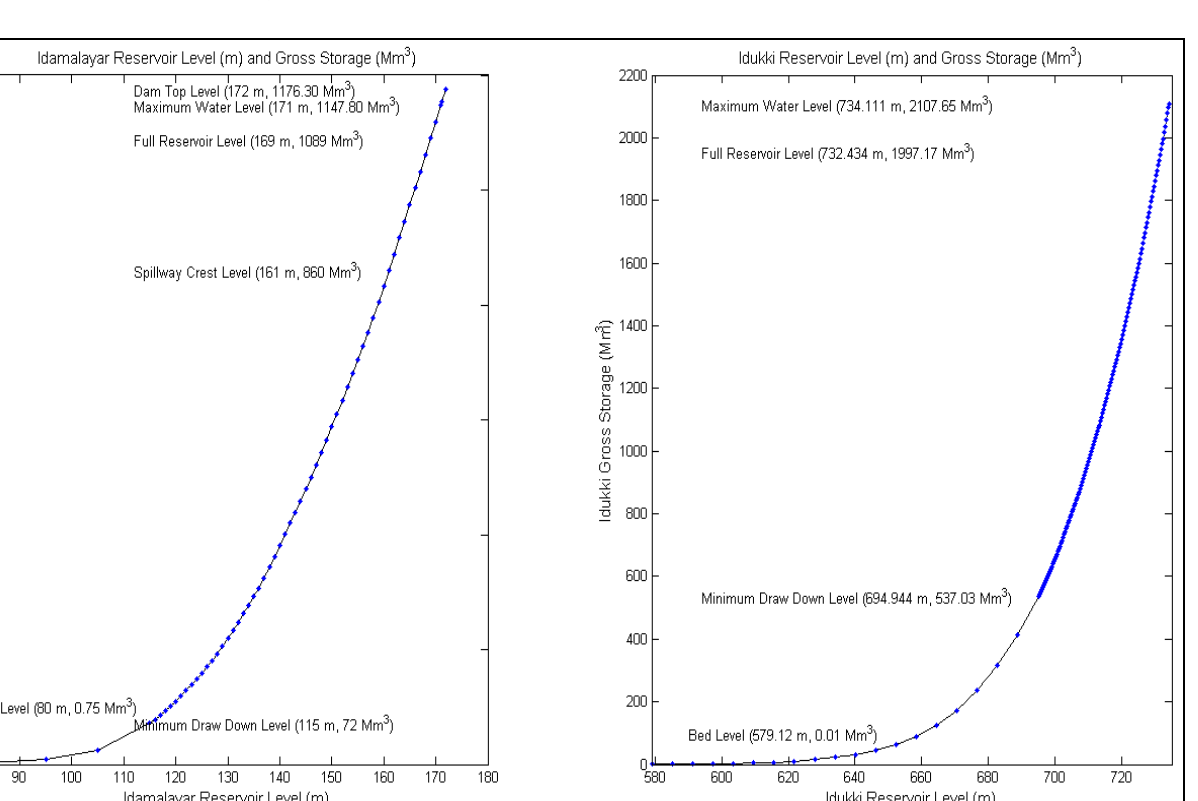
Figure 6. Idamalyar and Idukki available lower and upper rule curve.